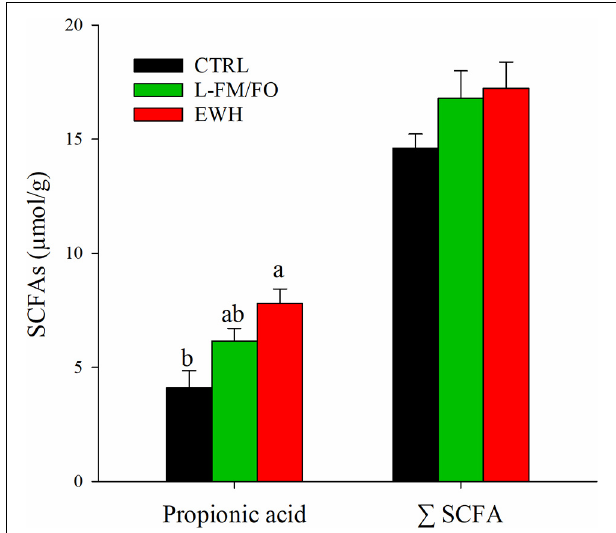
FIGURE 3 | Concentration of intestinal propionic acid and total short chain fatty acids ( (cid:54) SCFA) in fish fed CTRL (black bars), L-FM/FO (green bars), and EWH (red bars) diets. Significant differences (one-way ANOVA, Holm–Sidak post-test, P < 0.05) are indicated by different letters, which correspond to pairwise comparisons within each dietary group.